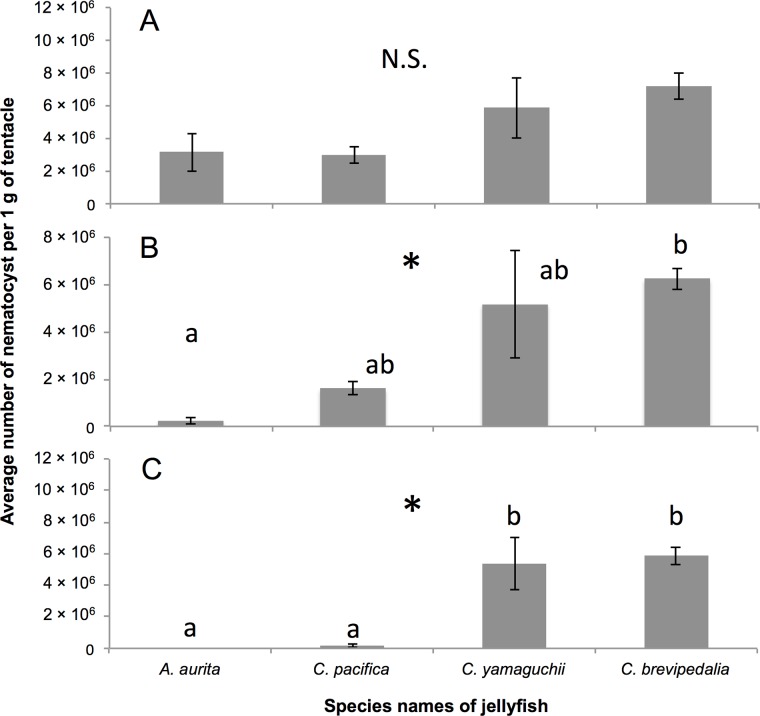
Average number of nematocyst per 1 g of tentacle.Average numbers ± SD of nematocyst in 1 g of tentacle from A. aurita, C. pacifica, C. yamaguchii, and C. brevipedalia. Ranges of tubule length are A: all, B: longer than 100 μm, and C: longer than 200 μm. N = 3 for each species. * indicates p < 0.05 one-way ANOVA. The same superscript letters (a, b) on the bar graph show that the bar belongs to the same group (Tukey’s test, p<0.05). N.S. indicates not significant.